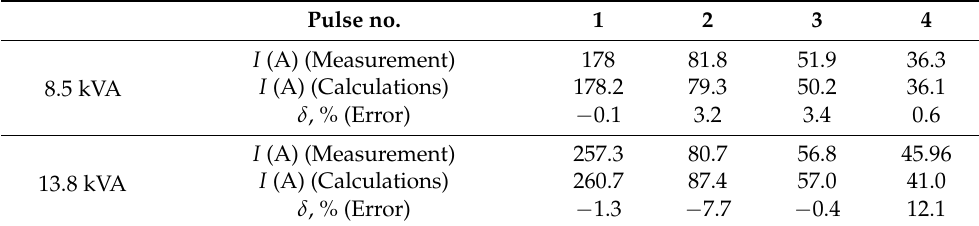
Table 4. Comparison of the maximum value of the inrush current pulses.